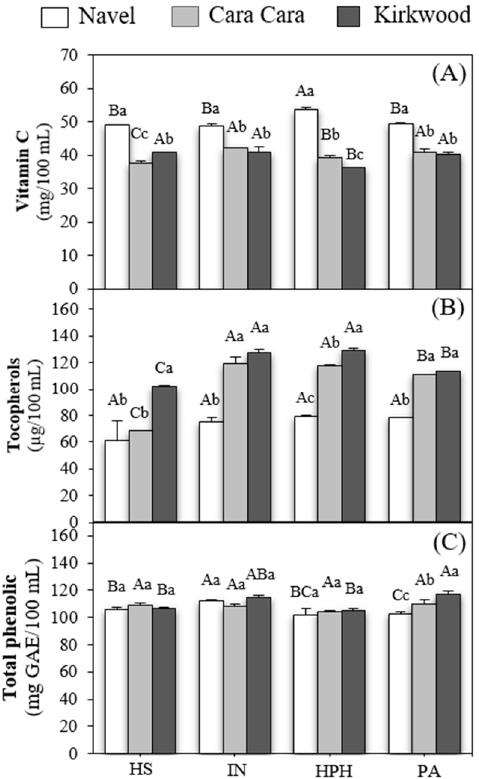
Figure 3. Content of vitamin C ( A ), tocopherols ( B ), and total phenolics ( C ) in hand-squeezed (HS), industrial (IN), HPH, and pasteurized (PA) juices of N, CC, and K orange. Uppercase letters indicate significant differences between different type of juices for the same variety, and lowercase letters indicate significant differences between varieties for the same type of juice by one-way ANOVA ( p <